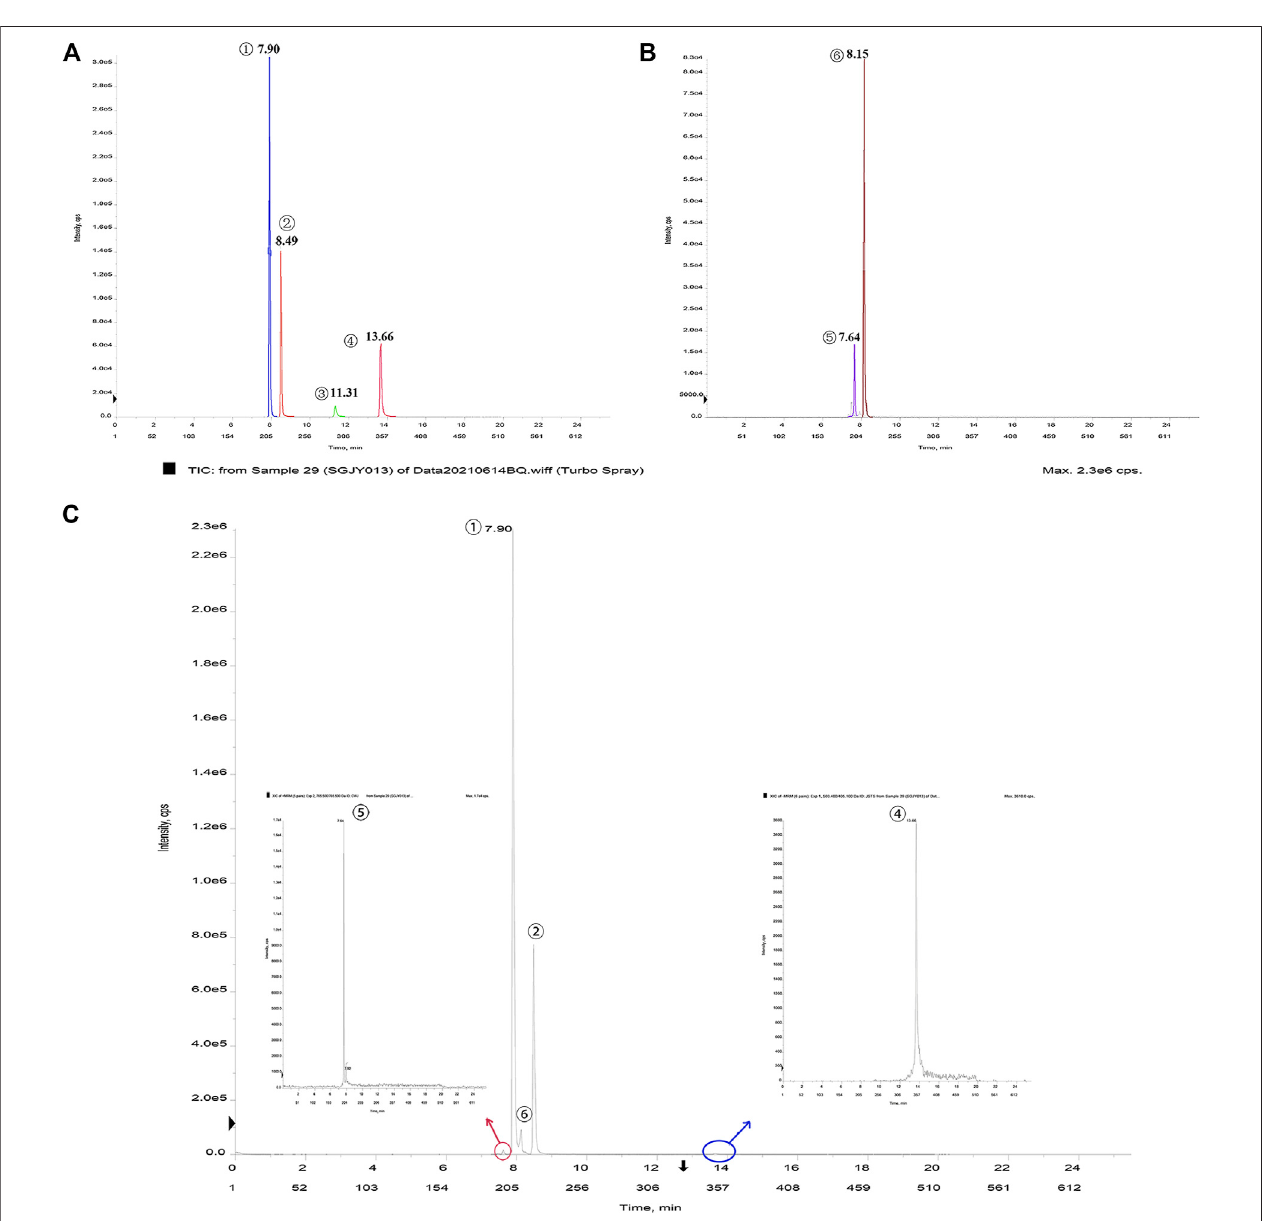
FIGURE 2 | (A) (B) LC-MS/MS analysis of the main chemical compounds found in SG. Retention times: ① Hyperoside, 7.90 min ② Quercetin, 8.49 min ③ Pseudohypericin, 11.31 min ④ Hypericin, 13.66 min ⑤ Eleutheroside E, 7.64 min ⑥ Isofraxidin, 8.15 min (C) LC-MS/MS analysis of SG (500